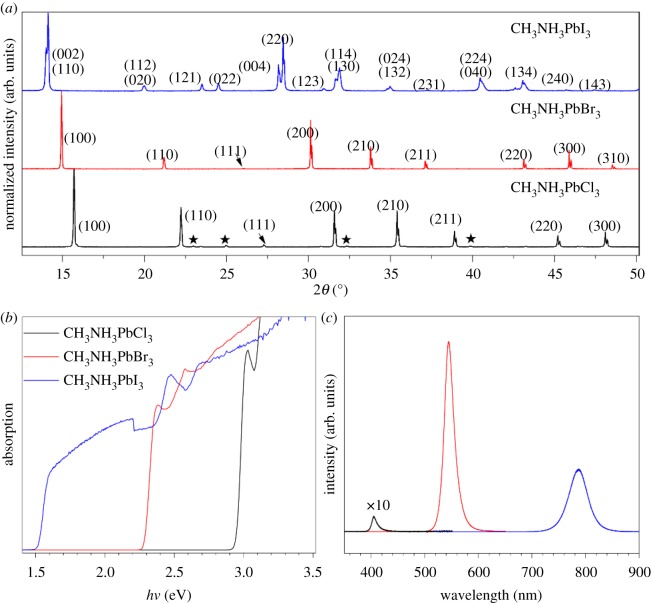
(a) Powder X-ray diffraction (XRD) patterns of the three crystals. CH3NH3PbCl3 and CH3NH3PbBr3 both belong to cubic phases, and CH3NH3PbI3 belongs to tetragonal phase. (b) The dependence of absorption of CH3NH3PbX3 on the photon energy. (c) Photoluminescence spectra of CH3NH3PbX3 crystals excited by 325 nm laser. For clarity, the photoluminescence intensity of CH3NH3PbCl3 was multiplied by 10 times.